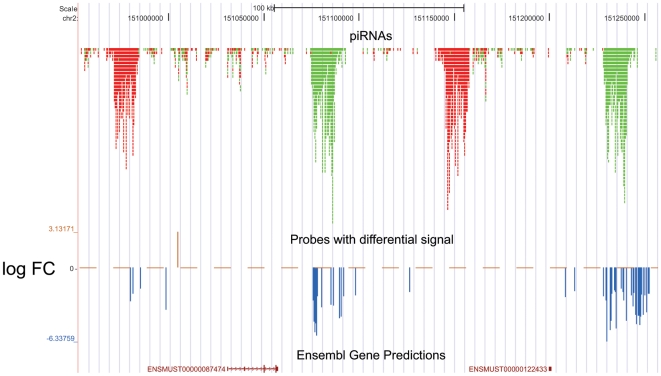
Downregulation of four piRNA clusters in chromosomal region chr2: 150,953,000–151,257,000.Three tracks are depicted. The upper one shows positions of piRNAs as obtained from piRNAbank (http://pirnabank.ibab.ac.in/). Reverse-strand piRNAs are shown in green, forward-strand piRNAs in red. Only the probes exhibiting significant differential intensity between Spr and B6 (P<0.05) are depicted in the middle track. Both clusters with reverse-strand piRNAs exhibit apparent abundance of downregulated probes. Predicted Ensemble transcripts are shown in the lowest track.